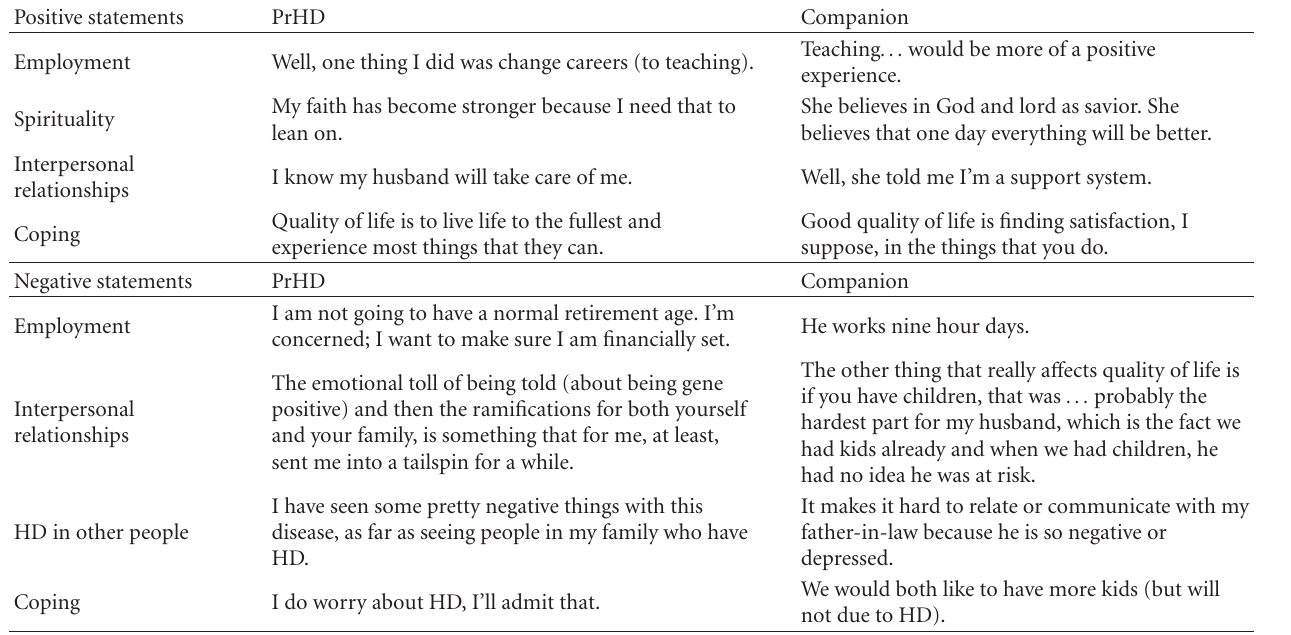
Table 3: Sample positive and negative QOL statements by content